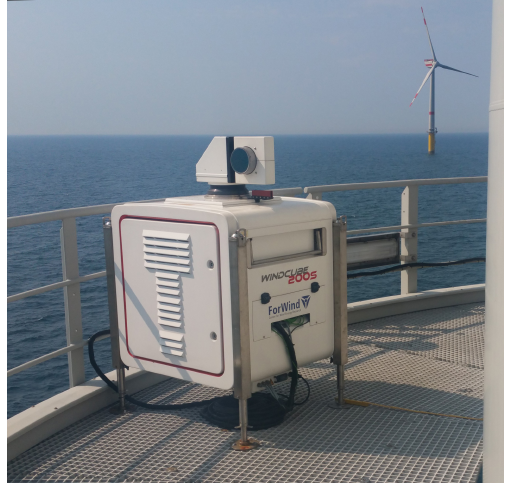
Figure 3. Lidar system Windcube 200S on the transition piece of wind turbine GT58 in the offshore wind farm Global Tech I. On the right side of the image the tower of the turbine is visible while turbine GT51 northwest of GT58 can be seen in the background (cf. GT I layout in Fig. 2) (Stephan Voß,